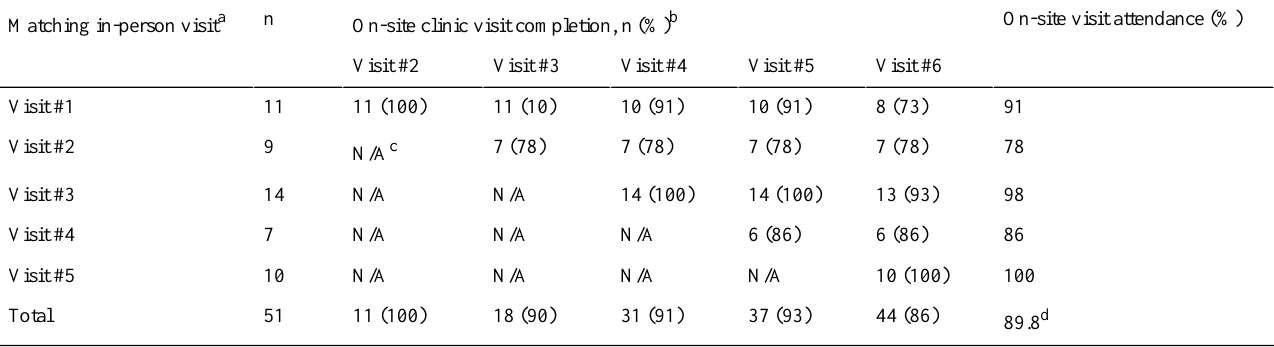
Table 3. Clinic visit attendance among smoking cessation clinical trial participants by last in-person visit for the pre–COVID-19 cohort (n=51).